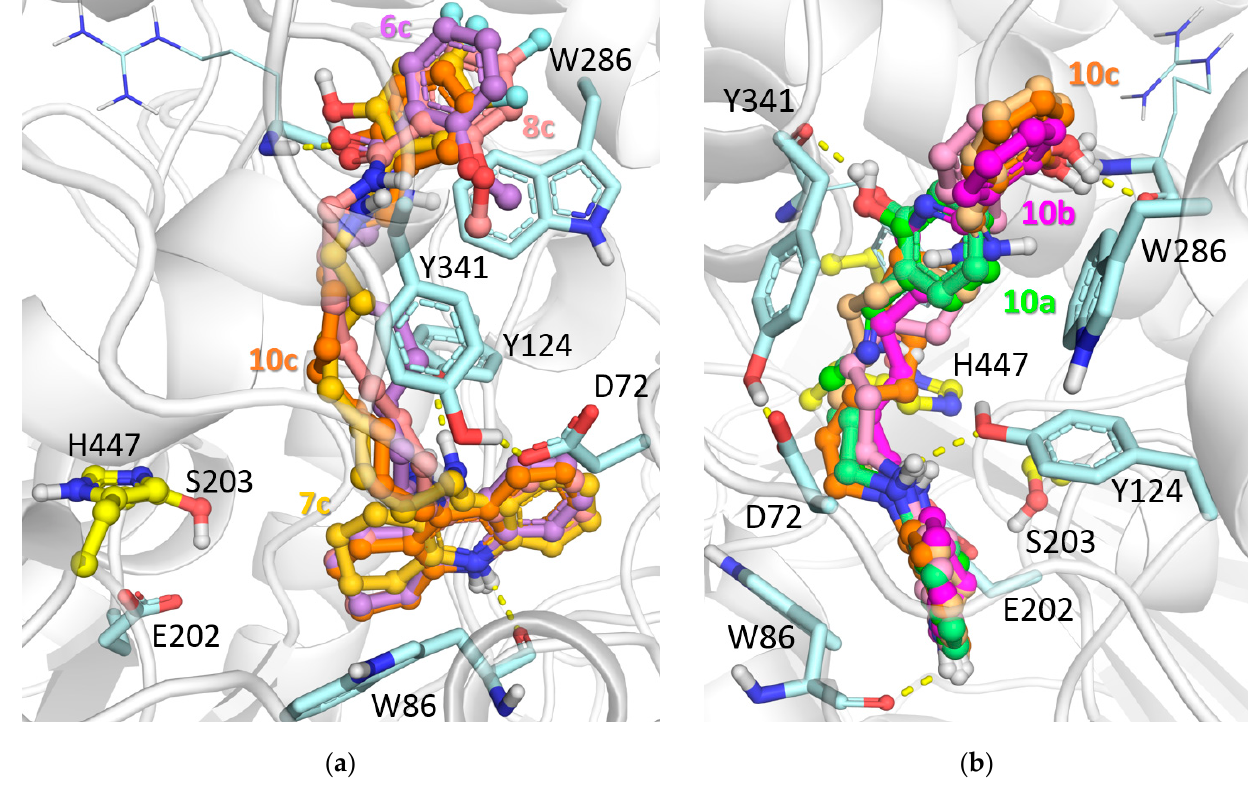
Figure 3. Molecular docking to the AChE active site of conjugates 6c (carbon atoms are colored lilac blue), 7c (carbon atoms are colored yellow), 8c (carbon atoms are colored pink), 10c (carbon atoms are colored orange) ( a ); and binding of non-protonated and protonated forms of 10a–c (carbon atoms of compound 10a are colored green, 10b —magenta, 10c —orange); carbon atoms of protonated forms are colored with a paler shade ( b ).